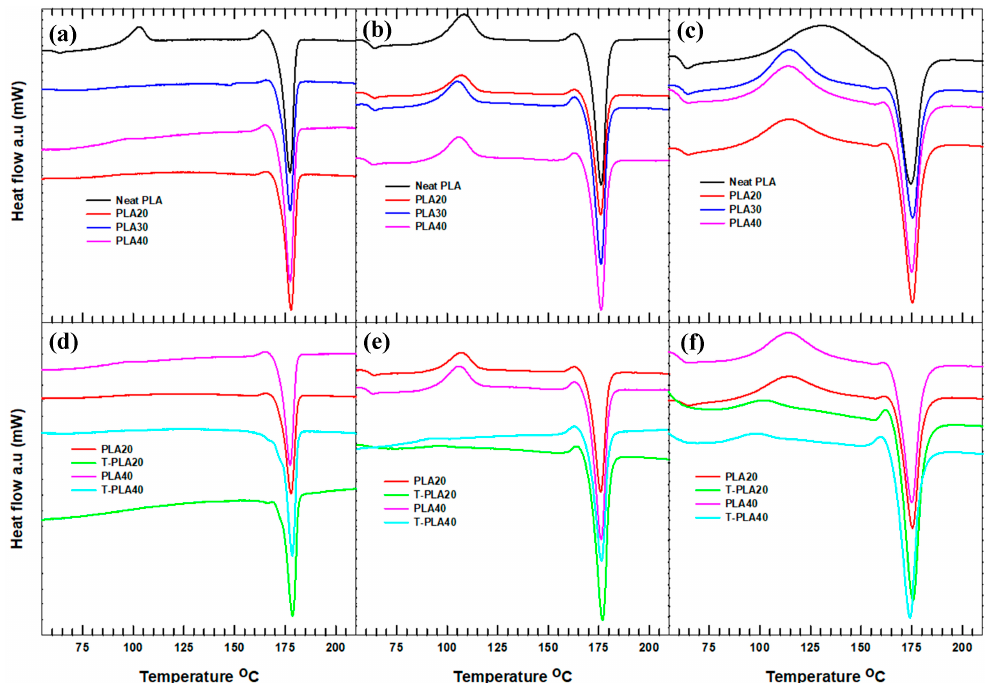
Figure 4. Cold crystallization and melting thermographs of neat and hybrid composites: effect of filler loading at heating rates of ( a ) 5°C/min, ( b ) 10°C/min, and ( c ) 20°C/min; effect of filler treatment at